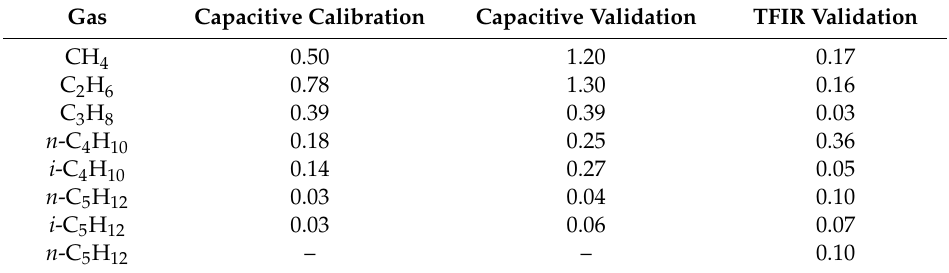
Table 3. Accuracy of the hydrocarbon concentrations derived from the (1) experiments with the capacitive sensor array: calibration experiments in Section 4.1, and from the validation experiments in Section 4.2, using mixtures of 7 gasses; (2) the experiments with the tunable filter infrared spectrometer, using mixtures of 3 gasses. Calculated as average di ff erence between calculated concentration and set-point, in